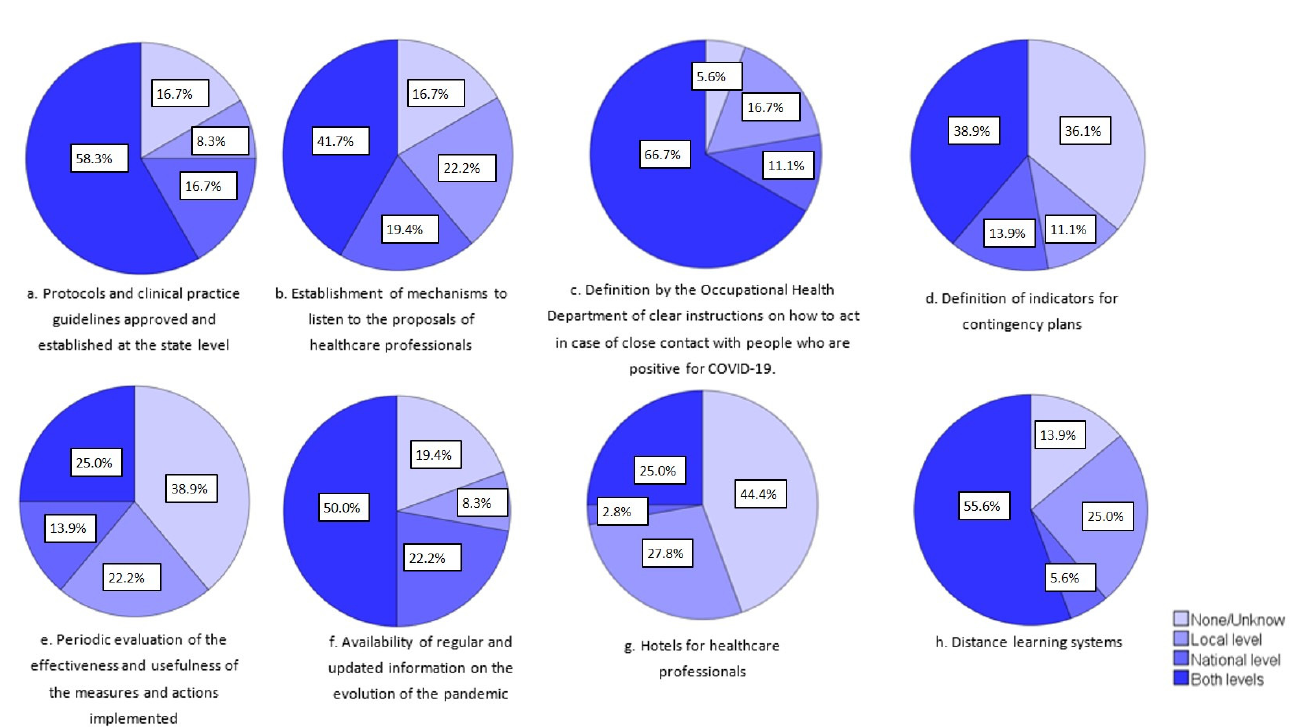
Figure 2. Organizational initiatives to respond to the challenges of the COVID-19 pandemic effectively from 35 countries (Argentina, Azerbaijan, Belgium, Bosnia and Herzegovina, Brazil, Bulgaria, Chile, Colombia, Croatia, Czech Republic, Denmark, Ecuador, Estonia, Finland, France, Germany, Ireland, Israel, Italy, Japan, Lithuania, Malta, Mexico, Netherlands, Peru, Poland, Portugal, Romania, Serbia, Slovakia, Spain, Sweden, Switzerland, Turkey, and the United States).